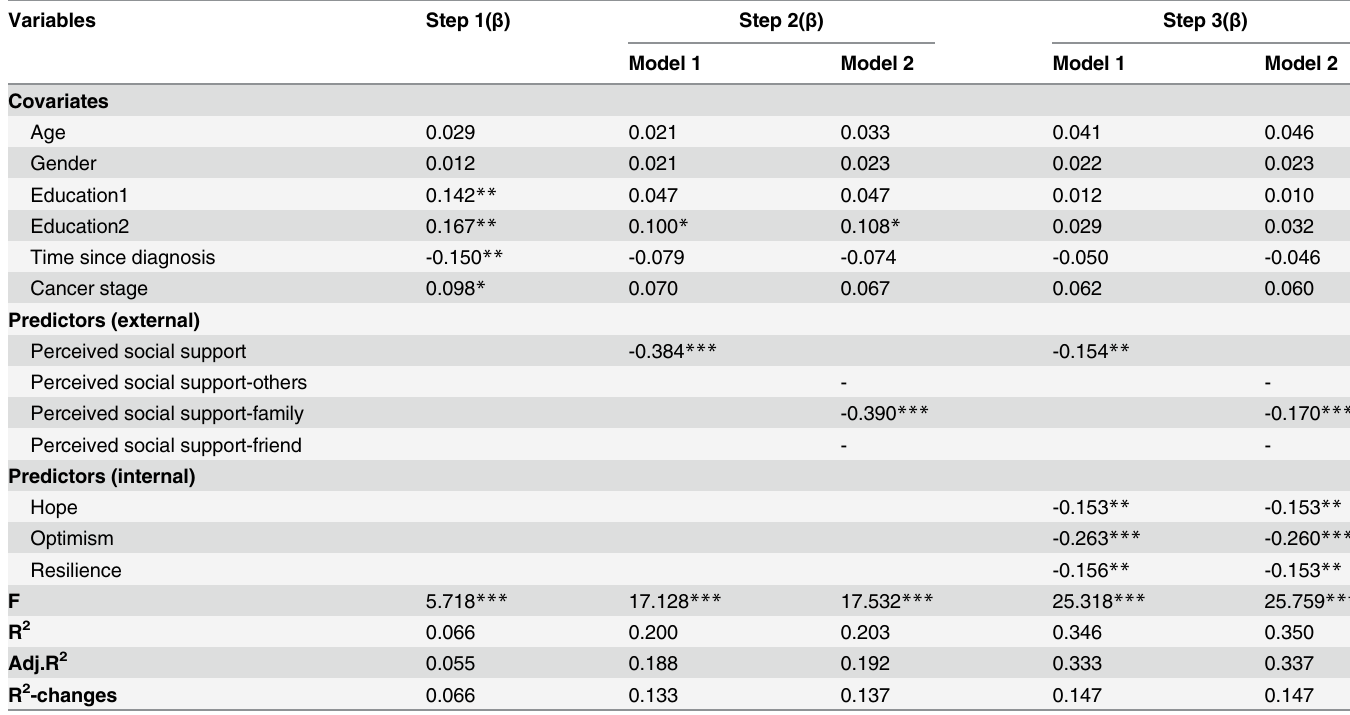
Table 6. Hierarchical regression analyses for psychosocial resources predicting